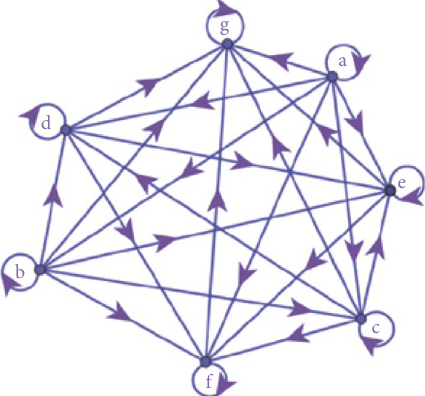
Figure 4: Validation of H G -graph Kannan mapping.